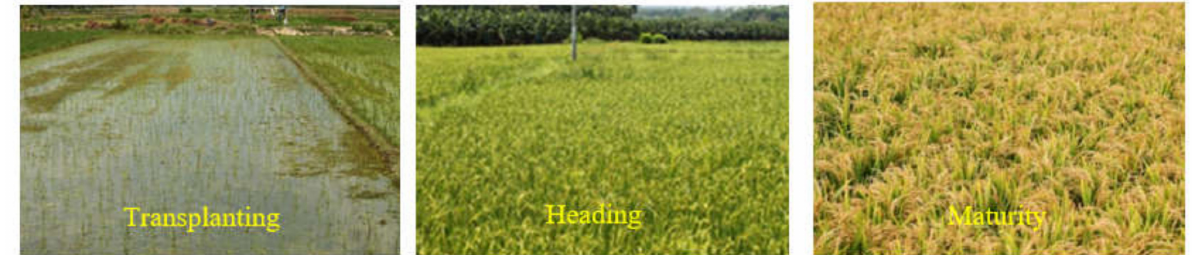
Figure 8. Typical growth map of the three key phenological stages of